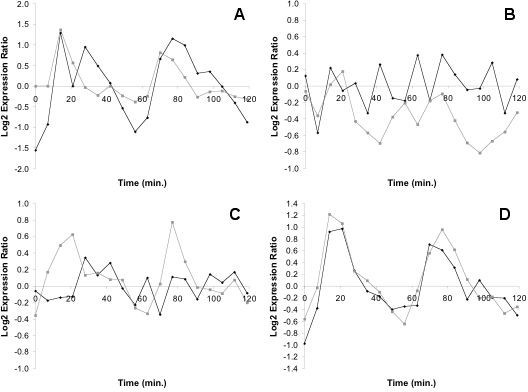
Fuzzy Model Fit to Numerical Data. Comparison of experimental (solid black line) gene expression ratios from the alpha cell synchronization data set (Spellman, et al., 1998) and the predicted time series of the best-fitting fuzzy model (grey line) for genes CLN1, E = 0.930 (A), CDC28, E = 0.510 (B), SWI6, E = 0.620 (C), and CLB5, E = 0.881 (D).